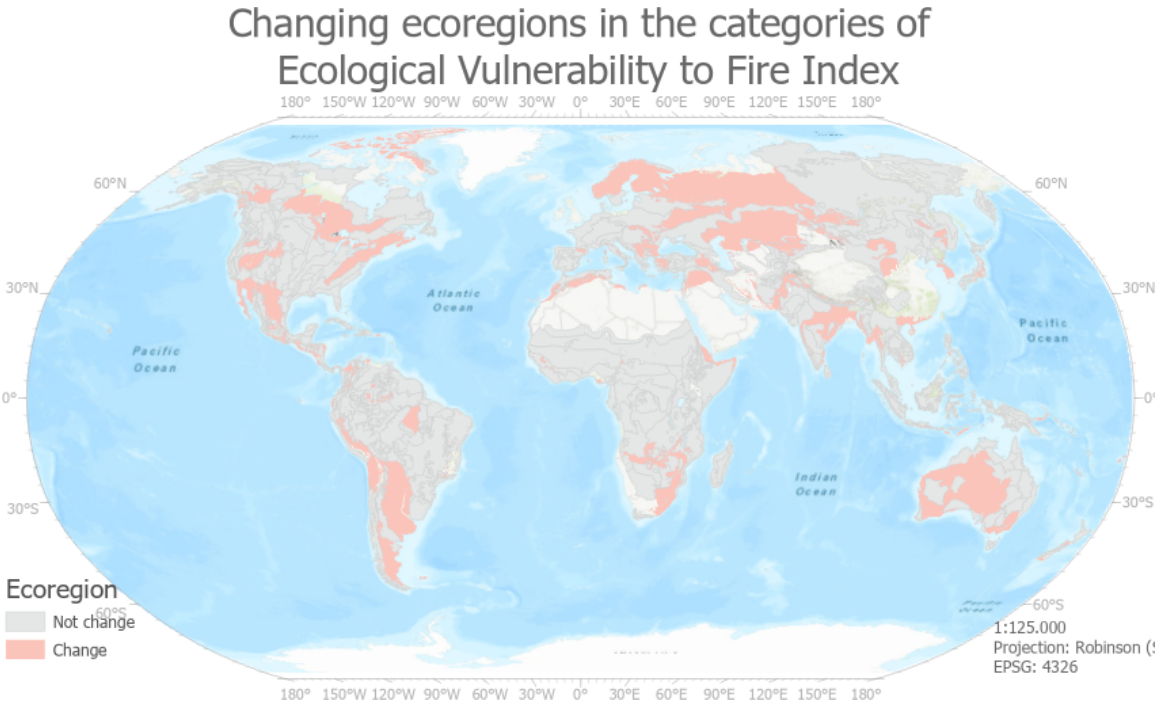
Figure A6. Spatial distribution of changing ecoregions in the categories of ecological vulnerability to fire index resulting from the OAT analyses (sensitivity method) (source: the